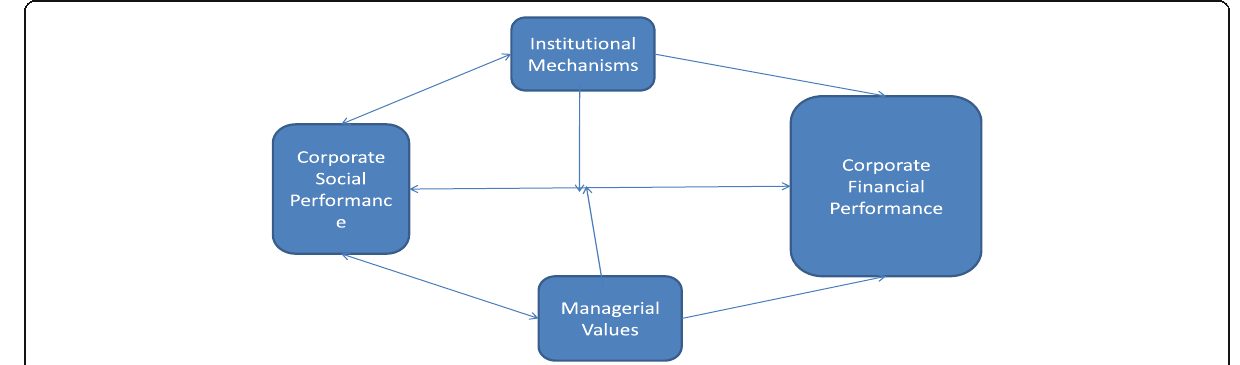
Fig. 1 Framework for mechanisms 4 CSR progress. Source: Author ’ s own